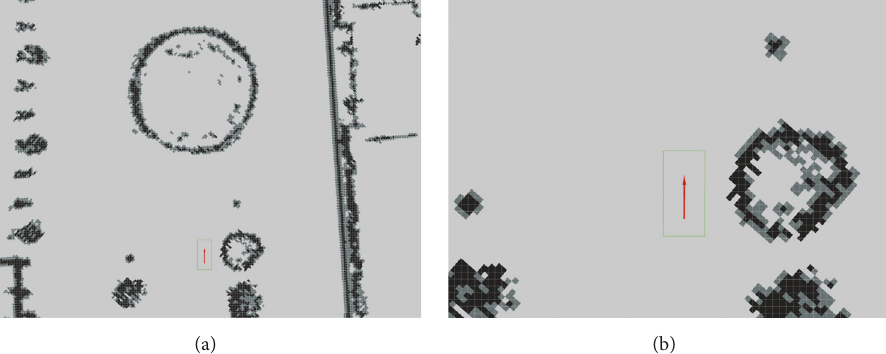
Figure 9: On (a), starting point of the vehicle oriented to the local odometry. On (b), zoom in the details of the vehicle geometry.